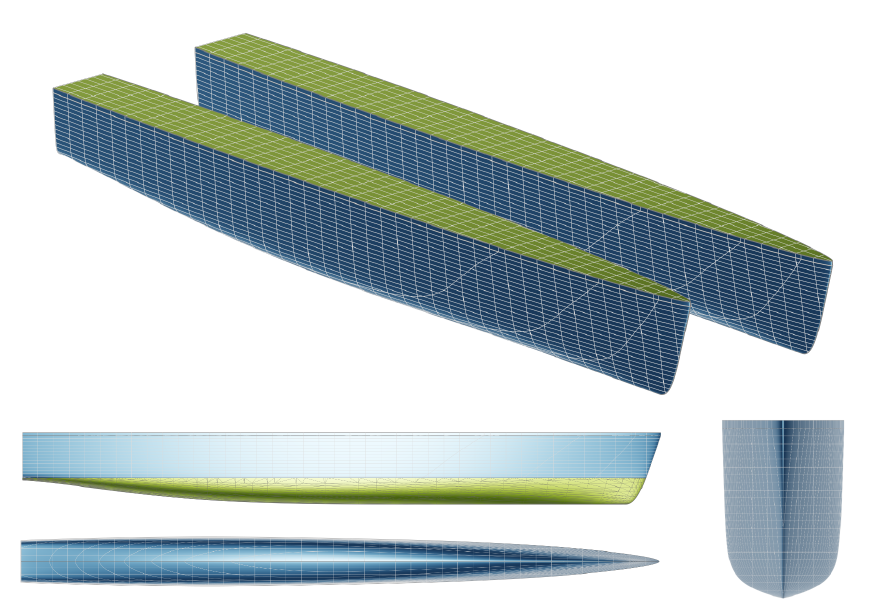
Figure 2. Baseline.